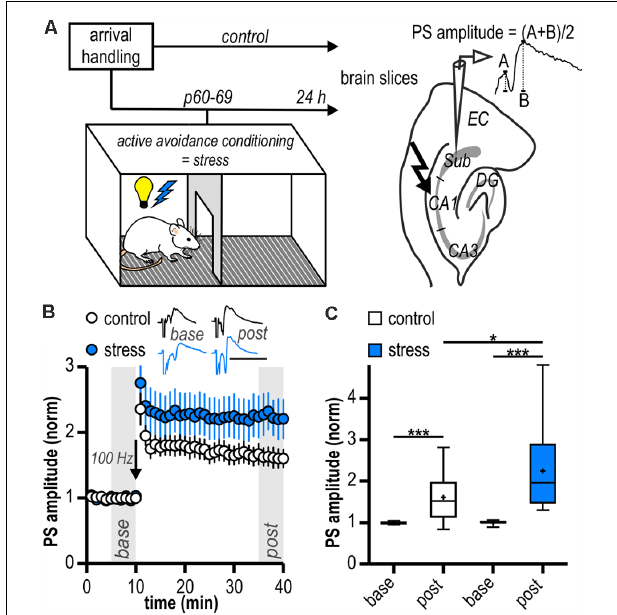
FIGURE 1 | Long-term potentiation (LTP) at ventral hippocampal CA1—subiculum synapses is enhanced following acute stress in adulthood. (A) Study design. Schematic drawing on the right illustrates the placement of the stimulation and recording electrodes in the hippocampal slice and the calculation of the population spike (PS) amplitude. (B) Time course of mean normalized PS amplitudes at CA1—subiculum synapses. LTP in the subicular field following high-frequency stimulation (HFS, 100 Hz, arrow) is significantly enhanced in stressed rats. Inset shows sample PS traces before ( base , min 6–10) and after ( post , min 36–40) HFS, scale bars: amplitude normalized to baseline of control, 50 ms. (C) Quantification of mean normalized PS amplitudes (control: n = 15/10, paired Student’s t -test, *** p < 0.001; stress: n = 12/6, Wilcoxon signed ranked test, *** p < 0.001; control vs. stress, unpaired Student’s t -test, * p < 0.05).